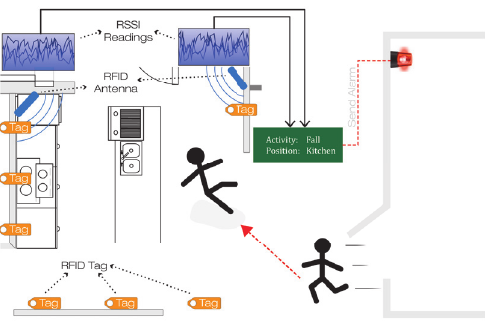
Figure 2: An illustraton of fall of an older